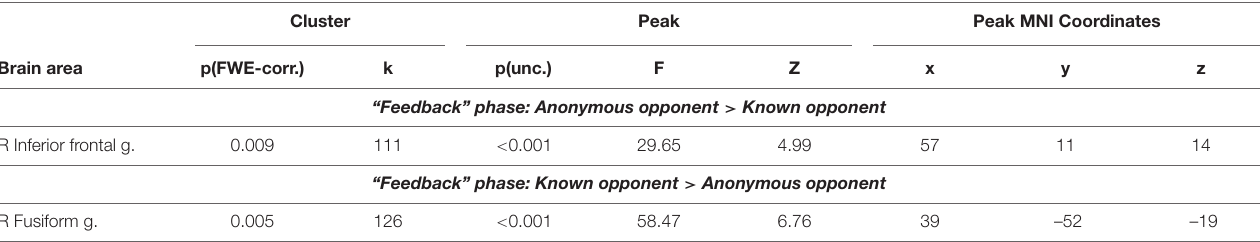
TABLE 3 | Results of the group-level analysis of the BOLD signal associated with the observation of provocation (uncorrected p < 0.001 at the voxel level, FWE corrected at the cluster level p < 0.05, and k = 15). Cluster Peak Peak MNI Coordinates Brain